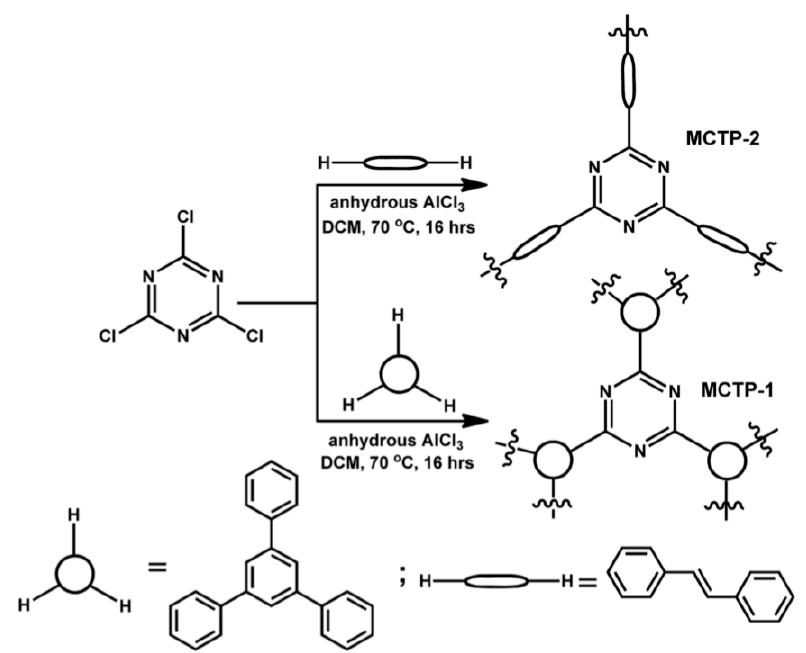
Scheme 2. Friedel-Crafts synthesis for microporous covalent triazine polymer formation.